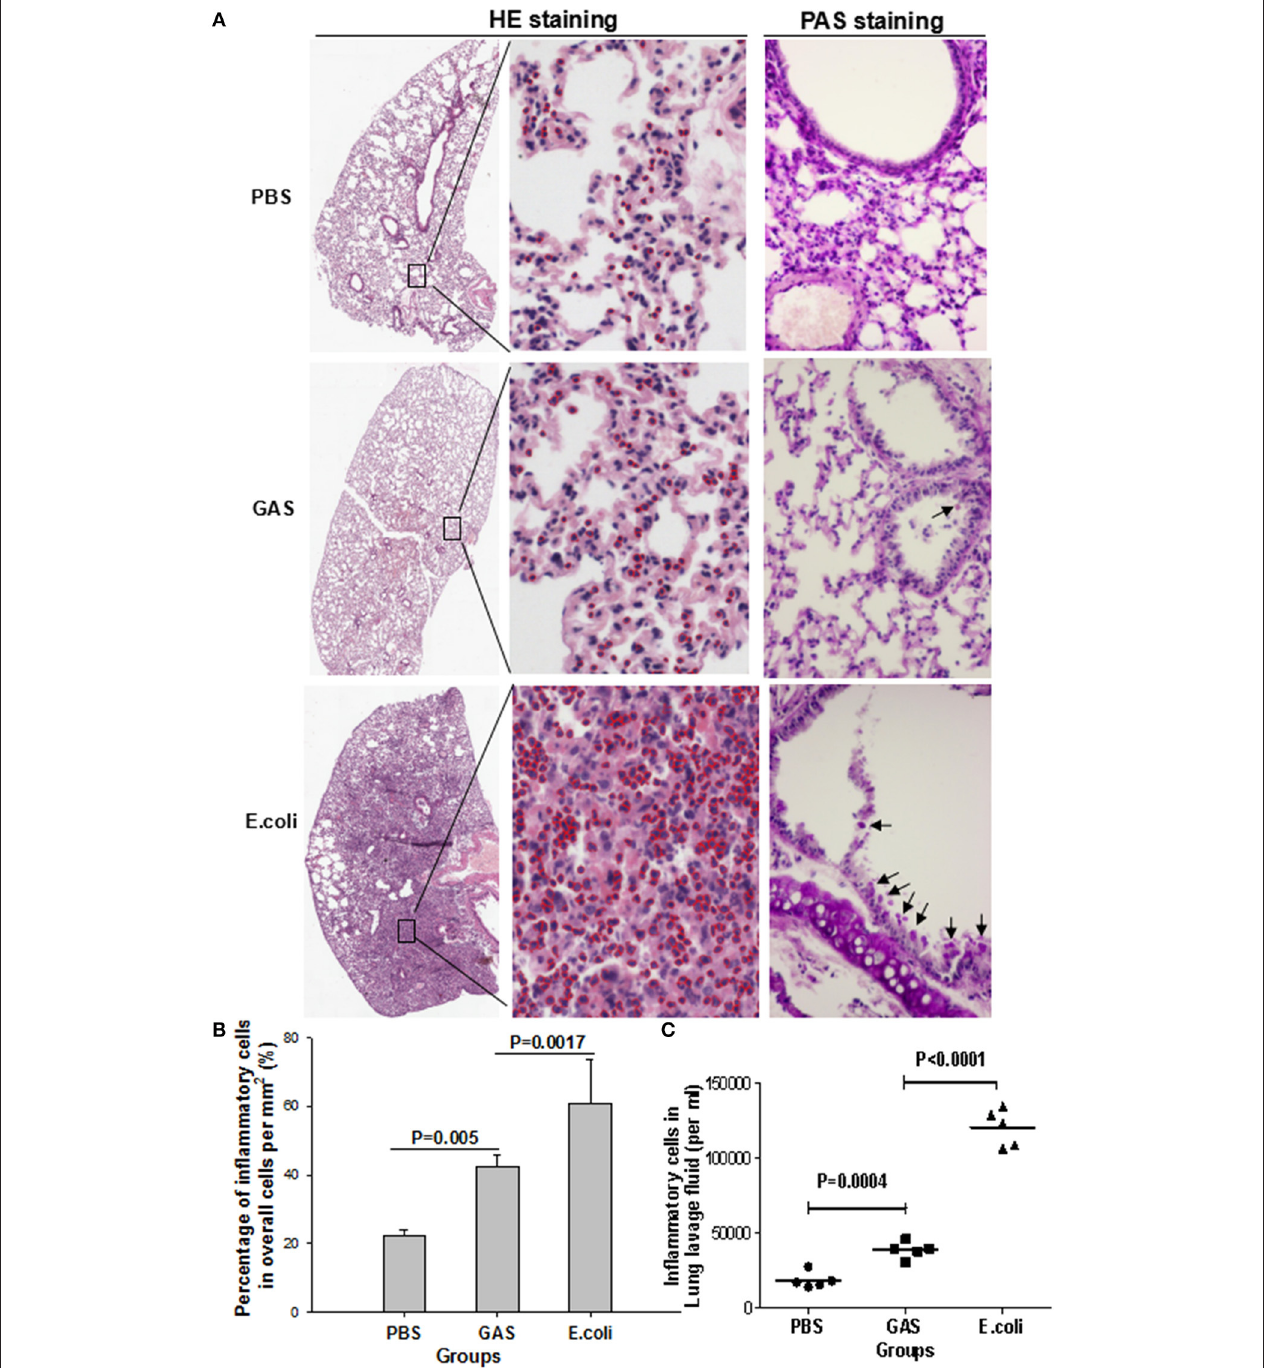
FIGURE 2 | Histological evaluation of inflammatory response in mouse lung tissue following GAS or E. coli infection. The three experimental groups of mice were separately prepared for histopathological analysis. (A) Representative views of lung sections treated with PBS, GAS, or E. coli. In the left panels, H&E staining shows the overall outline of lung slices, with a magnified image. Inflammatory cells are identified by red circles in the middle panels (H&E staining, × 10 and × 40). Periodic acid–Schiff (PAS) staining showed bronchiolar mucus production in each group (right panels, objective × 20). (B) Quantitative analysis of recruited inflammatory cells per square mm. (C) Inflammatory cells were counted in lung lavage fluid (per ml). Each experiment was repeated three times, and similar results were obtained on each occasion.